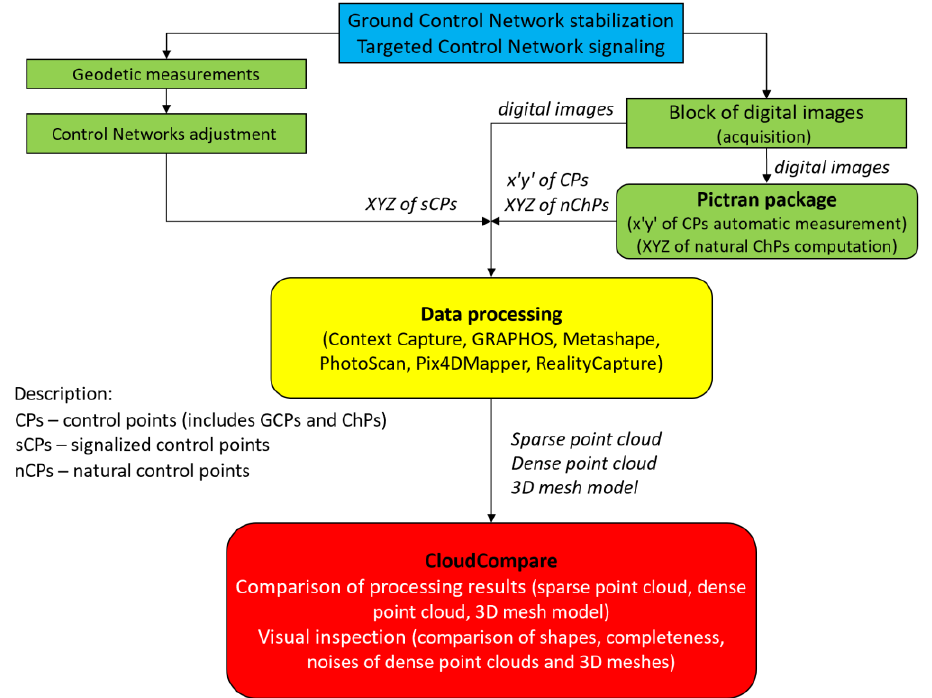
Figure 7. The workflow for CRBeDaSet tests in different applications dedicated to 3D object model- ing and reconstruction. and